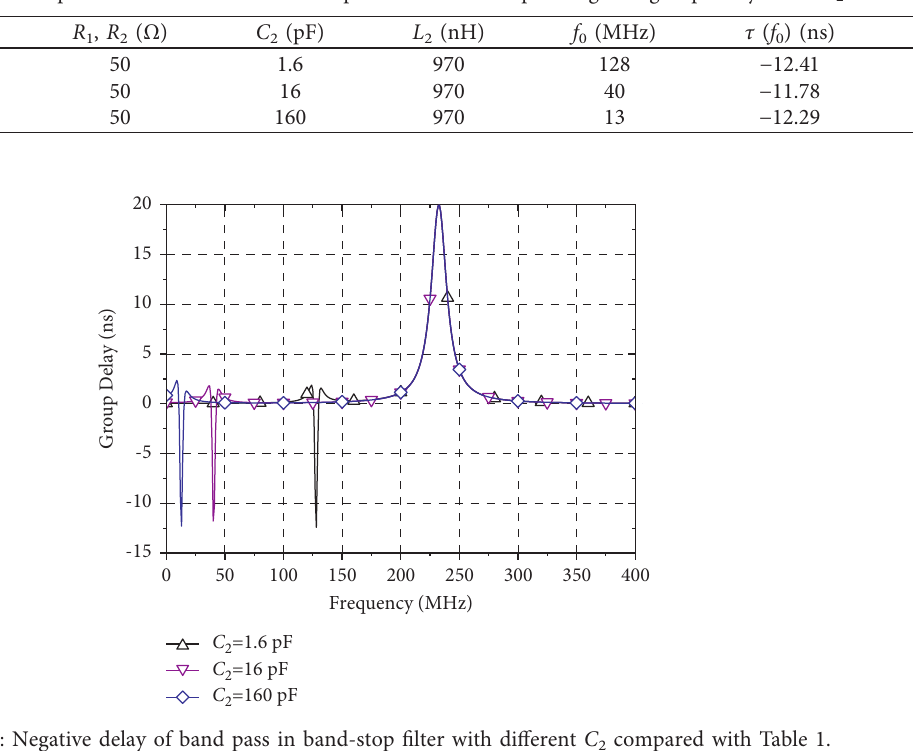
Figure 5: S parameters of the band-stop filter with band-pass negative group delay at different L Table 2: Element value and performance index of band-stop filters with band-pass negative group delay when C